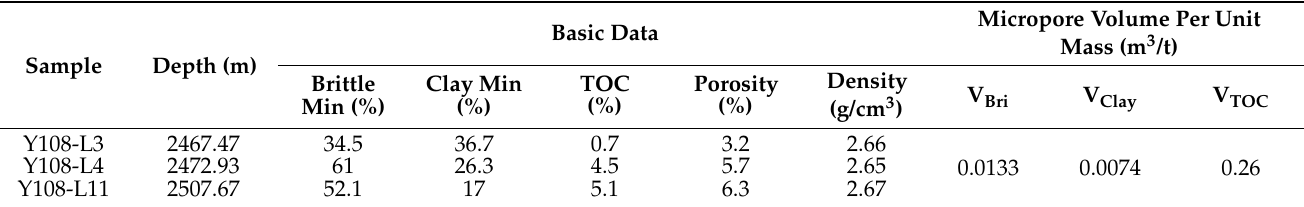
Table 2. Sampling point parameters in the Wufeng–Longmaxi Formation.